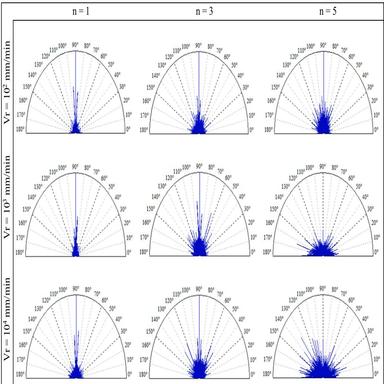
Morphological roses: effect of burnishing number of passes and speed on the surface texture directionality.